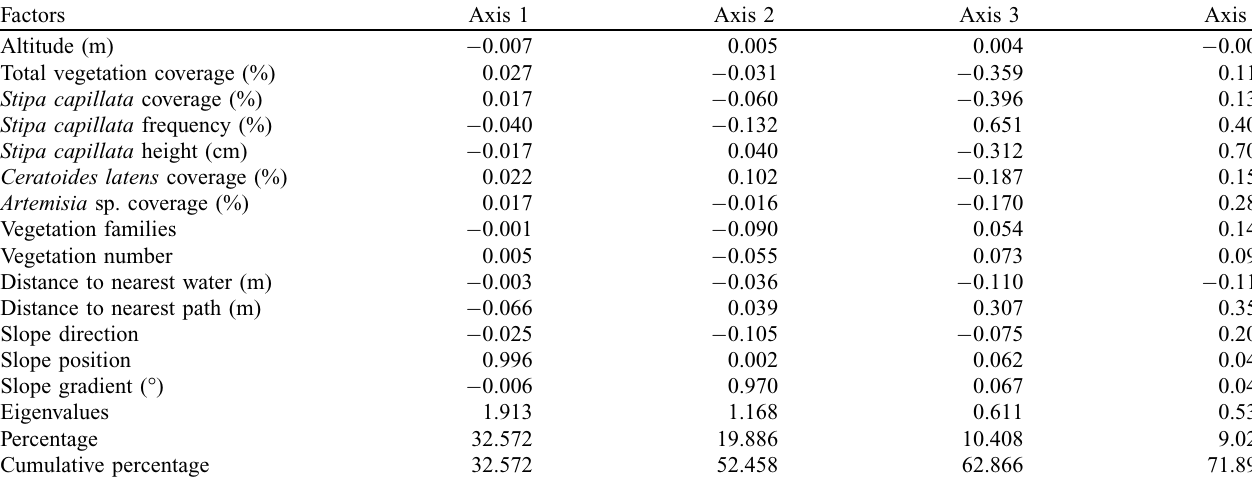
Table 3. PCA variable loadings among the oviposition site selection by G . pecorum associated factors. Factors Axis